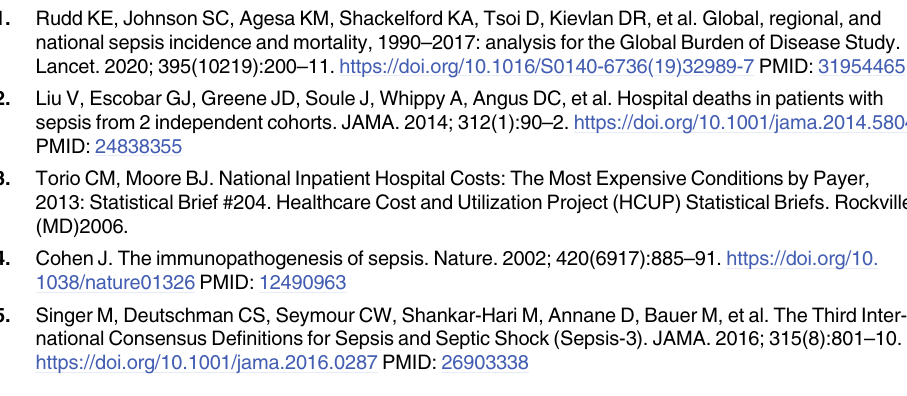
S3 Fig. Impact of Agr status on cytokine levels early during infection. Fold-changes in aver- age cytokine levels for every animal in the rabbit infection models in the early 6–24 h infection window were analyzed dependent on infection group (wild-type versus Δ agr -infected ani- mals). Statistical analysis is by unpaired two-tailed t-tests. Error bars show the geometric mean and geometric SD. NS, not significant (p � 0.05).